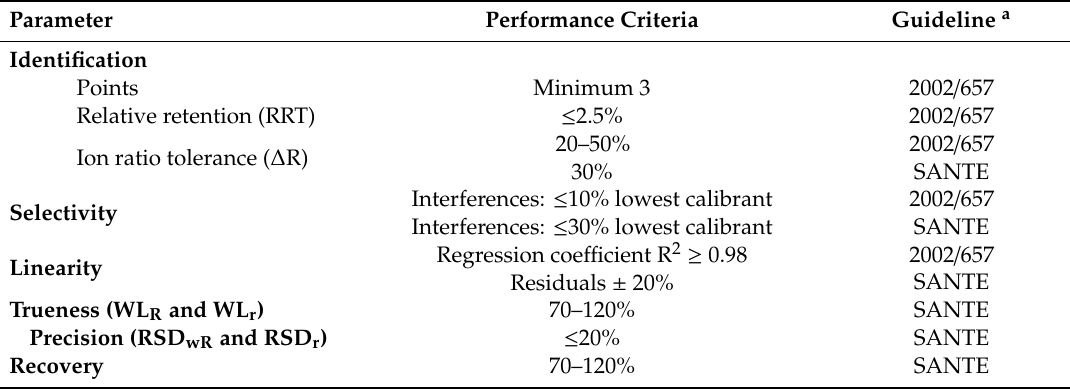
Table 1. Validation criteria adhered to, with corresponding legislative